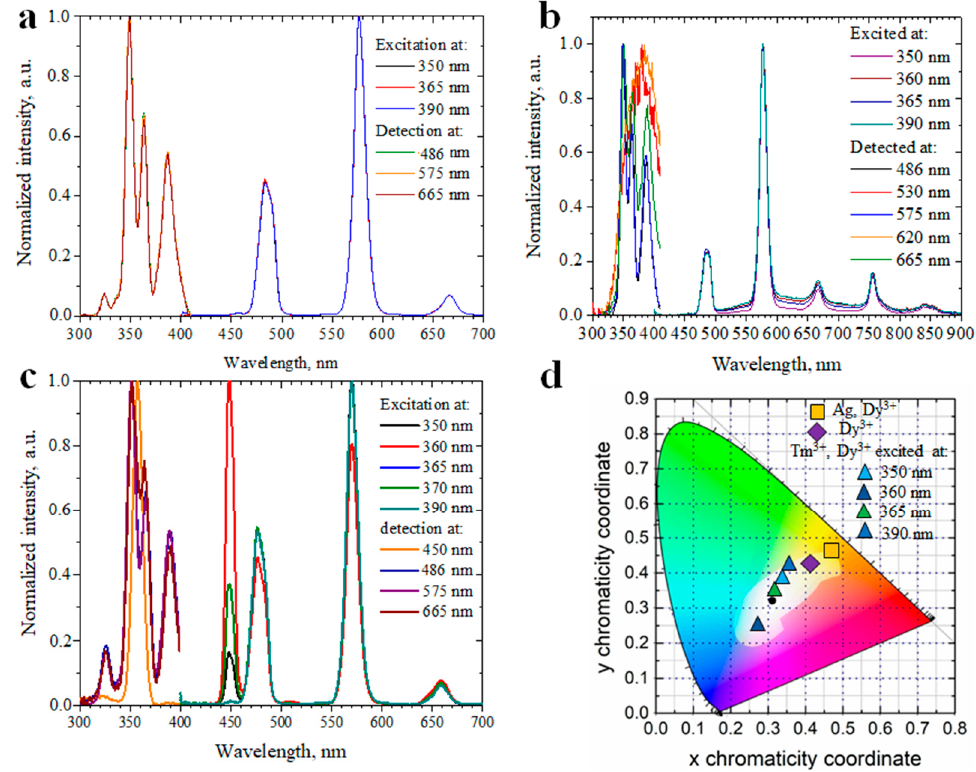
Figure 1. Room temperature steady-state photoluminescence and excitation spectrum of Dy-doped ( a ), Ag and Dy co-doped ( b ), and Tm and Dy co-doped ( c ) oxyfluoride glasses. Chromaticity CIE diagram ( d ) with emission color of the respective glasses at different excitation